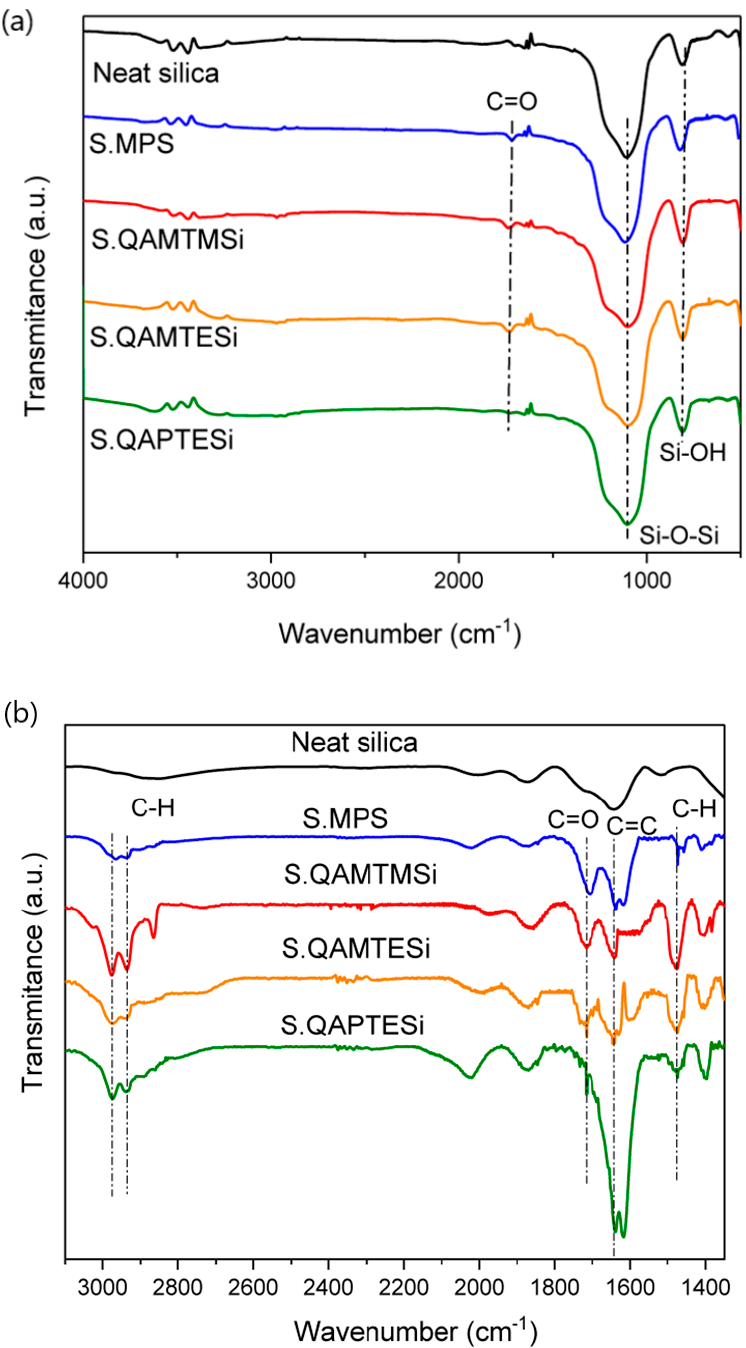
Figure 3. Comparative FTIR spectra in the scanning ranges of: ( a ) 4000–500 cm − 1 ; ( b ) 3200–1350 cm − 1 between neat and diverse organomodified silica